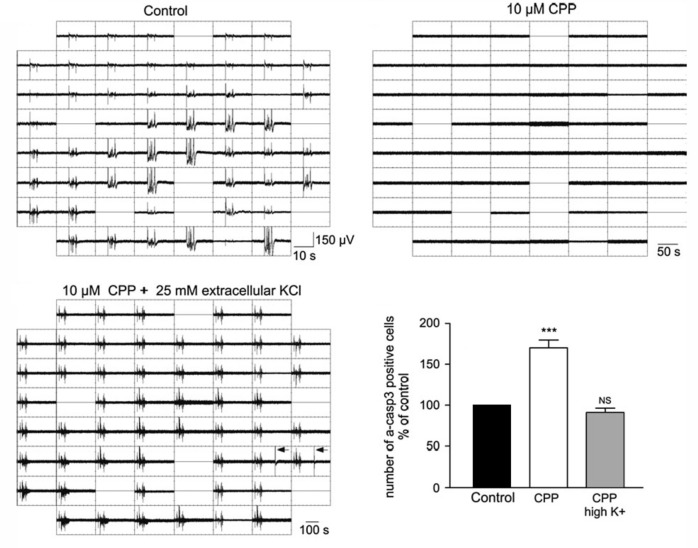
Influence of neuronal activity on apoptosis. Electrophysiological recordings and determination of apoptotic cells by activated Caspase3 immunohistochemistry in dissociated cortical cultures reveal that the NMDA receptor antagonist CPP blocks neuronal activity and enhanced apoptosis (***p < 0.001, Kruskal-Wallis test). This effect of CPP on apoptosis can be rescued in the presence of high K+ concentration, which restores the electrical activity (modified from Heck et al., 2008).